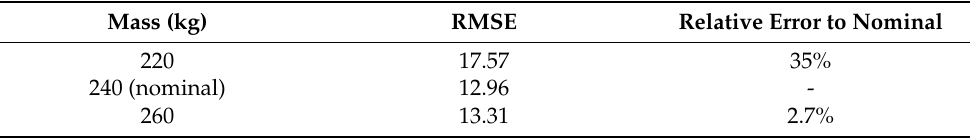
Table 3. Parameters for the simulation of the quarter-car suspension model and